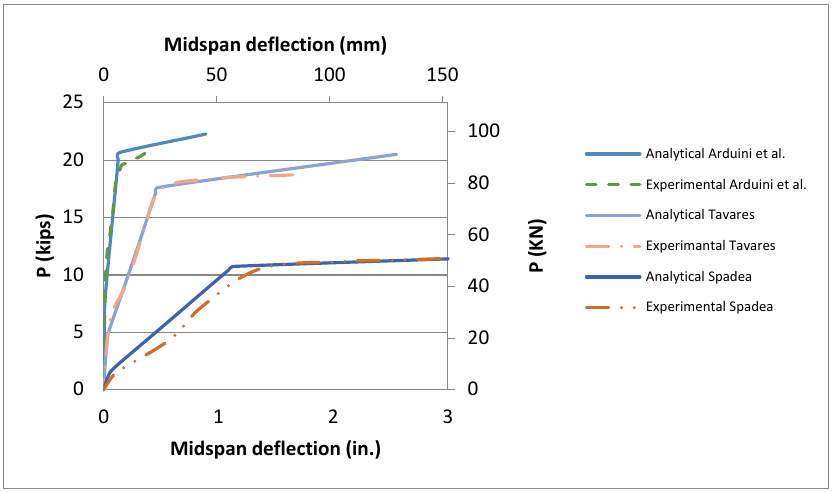
Figure 8. Arduini et al., (1997) [14], Tavares et al., (2008) [13] and Spadea et al., (1998) [15] load vs. midspan deflection comparisons.